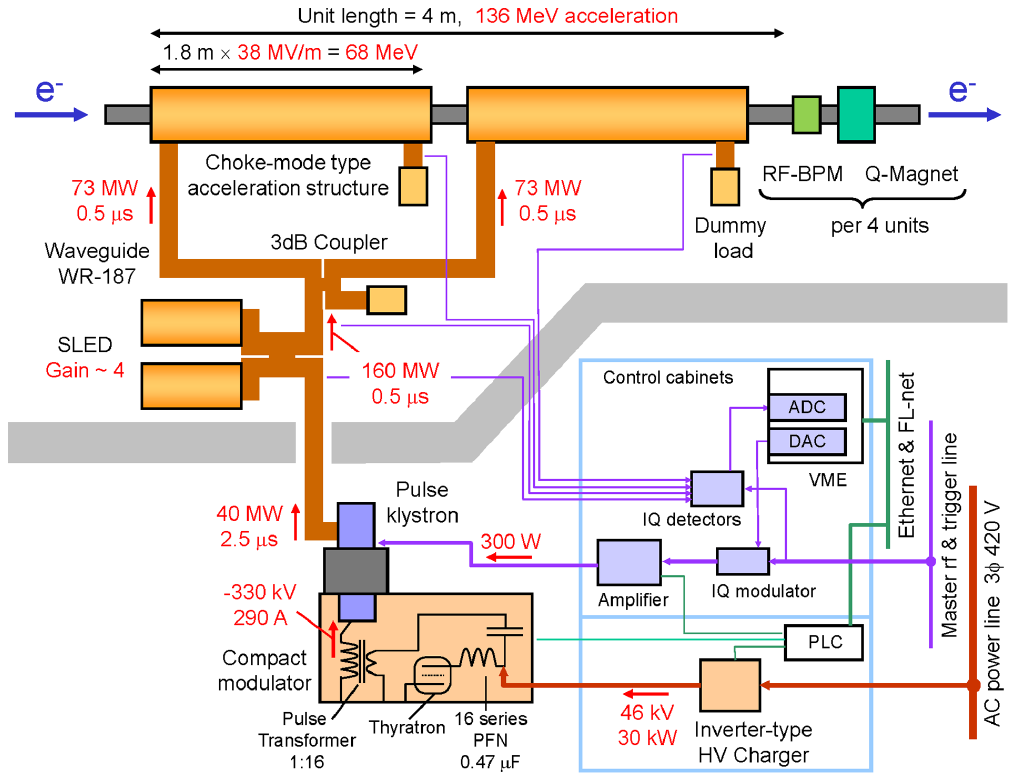
FIG. 2. Configuration of the C -band accelerator unit. Typical parameters for nominal operation are given in the